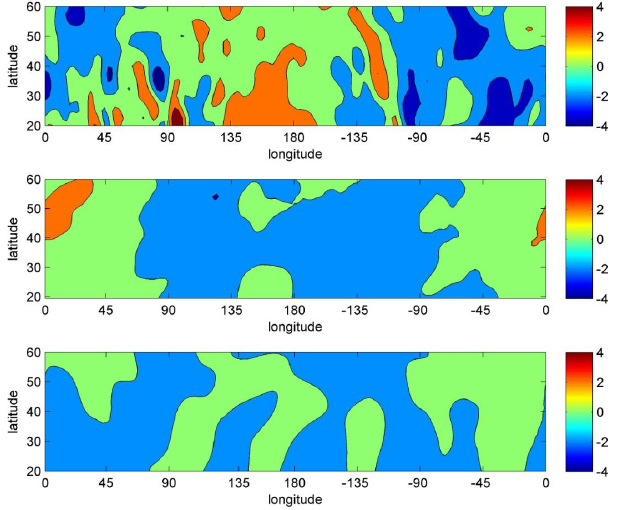
Figure 5. Plot of average geopotential height (km) for January 1958–2012 at 20–60 ◦ N, 180 ◦ E–180 ◦ W. Top panel: NCEP/NCAR (1958–2012); middle: ERA-Interim (1979–2012); bottom: